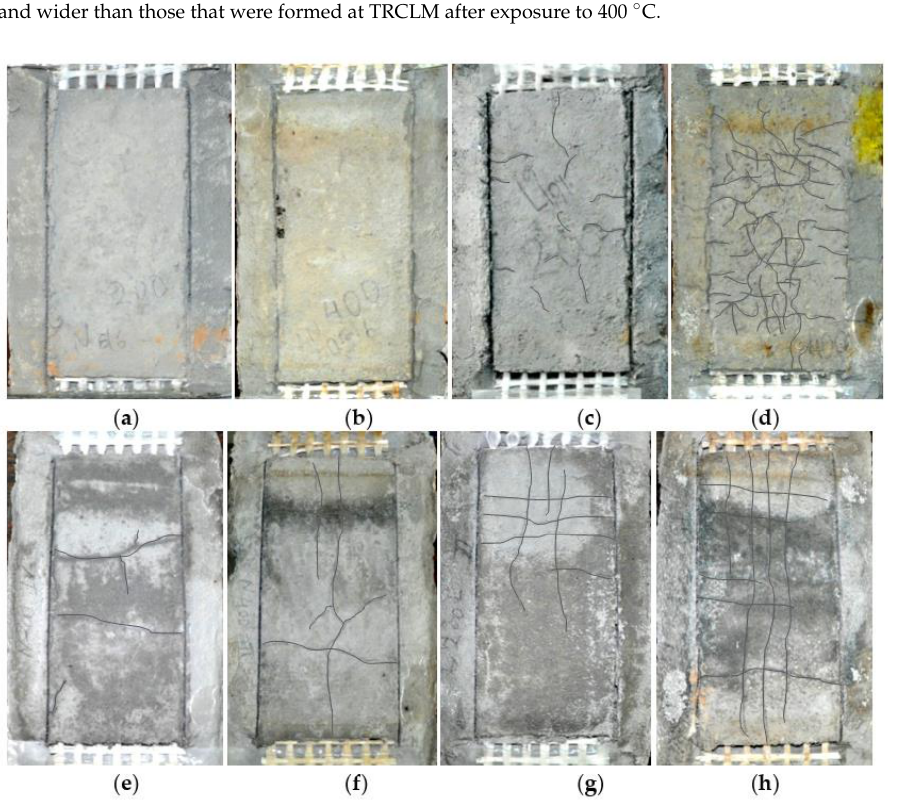
Figure 8. SL/SP specimens after their heating: ( a ) TRCNM200, ( b ) TRCNM400, ( c ) TRCLM200, ( d ) TRCLM400, ( e ) TRAANM200, ( f ) TRAANM400, ( g ) TRAALM200, and ( h ) TRAALM400. ( d ) TRCLM400, ( e ) TRAANM200, ( f ) TRAANM400, ( g ) TRAALM200, and ( h )